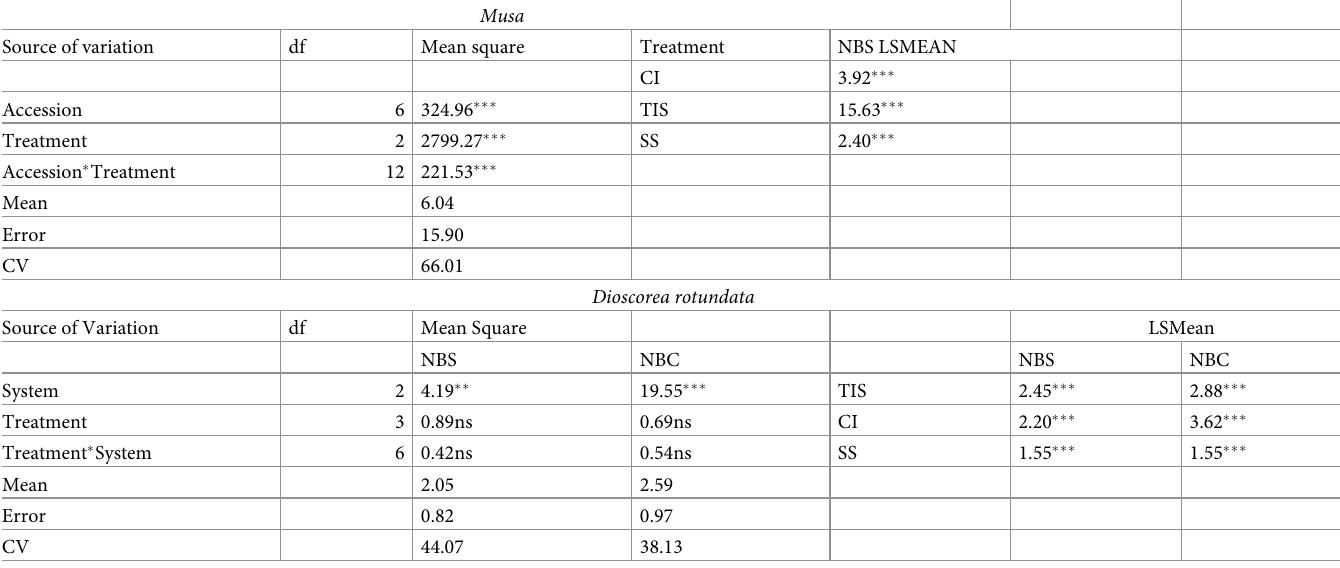
Table 2. ANOVA summary for in vitro Musa spp. and Dioscorea rotundata